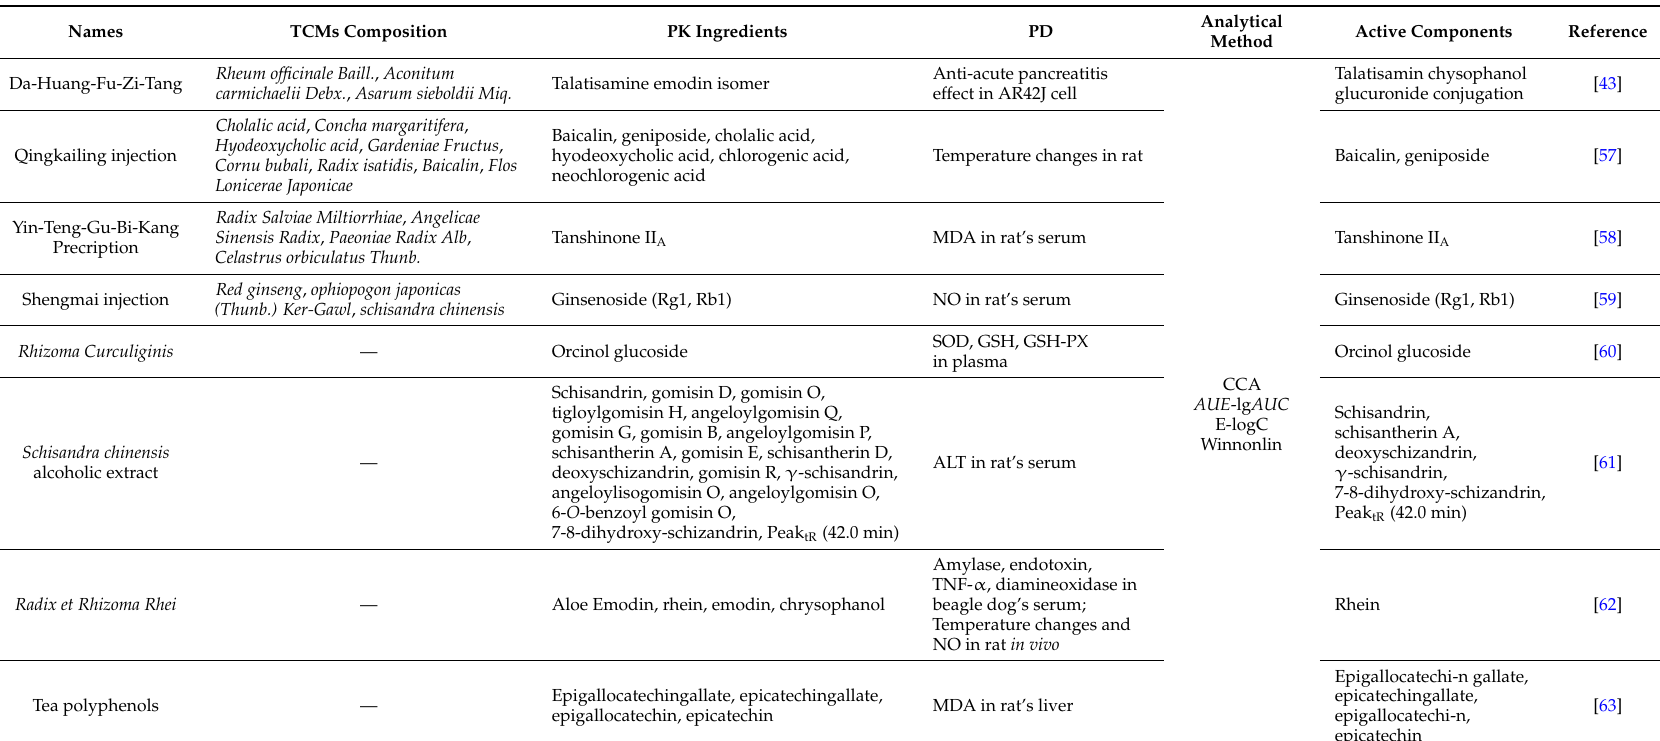
Table 3. Study on the pharmacokinetics (PK)-pharmacodynamics (PD) relationships in